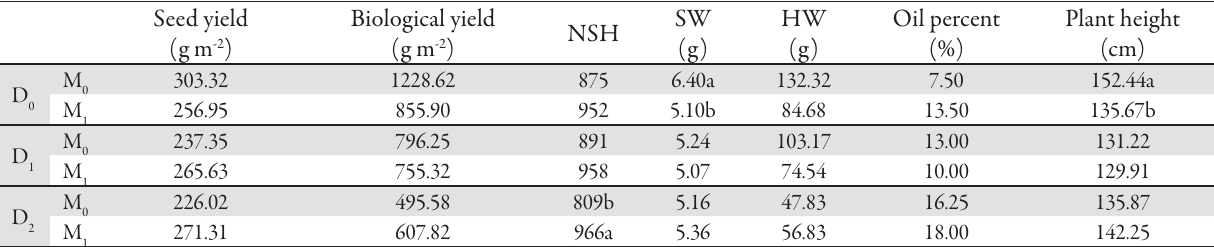
Tab. 3. Interaction effects of defoliation and Mn applications on oil percentage, biological and seed yield, yield components and plant height of sunflower